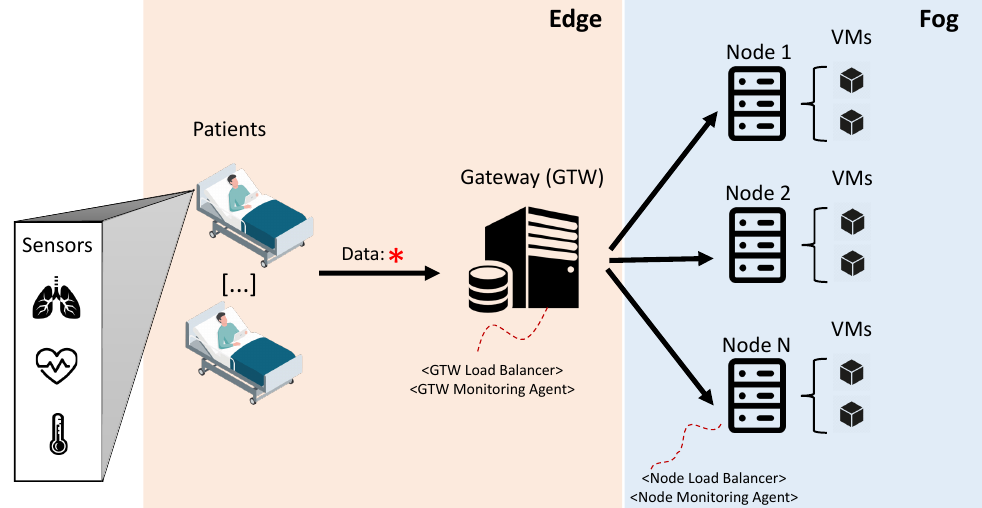
Figure 1. Overview of the scenario considered in the modelling